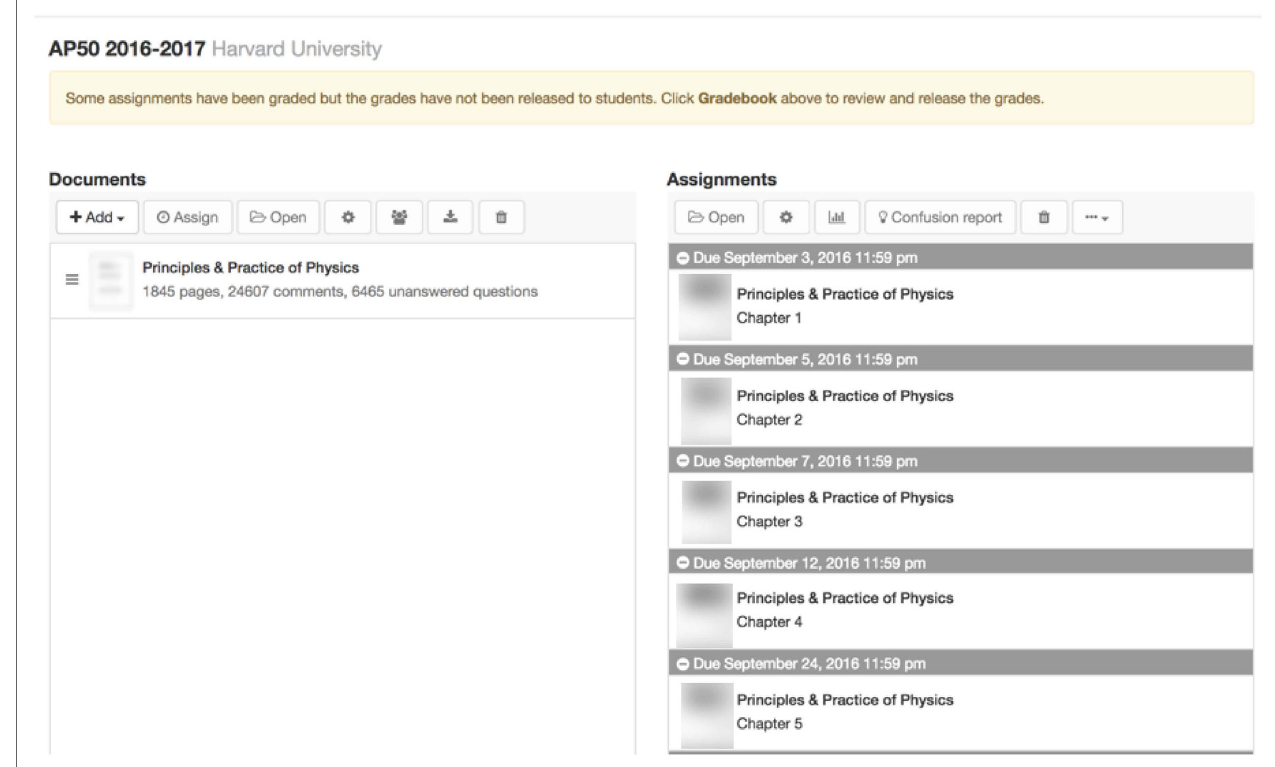
FigUre 1 | Persuall instructor course